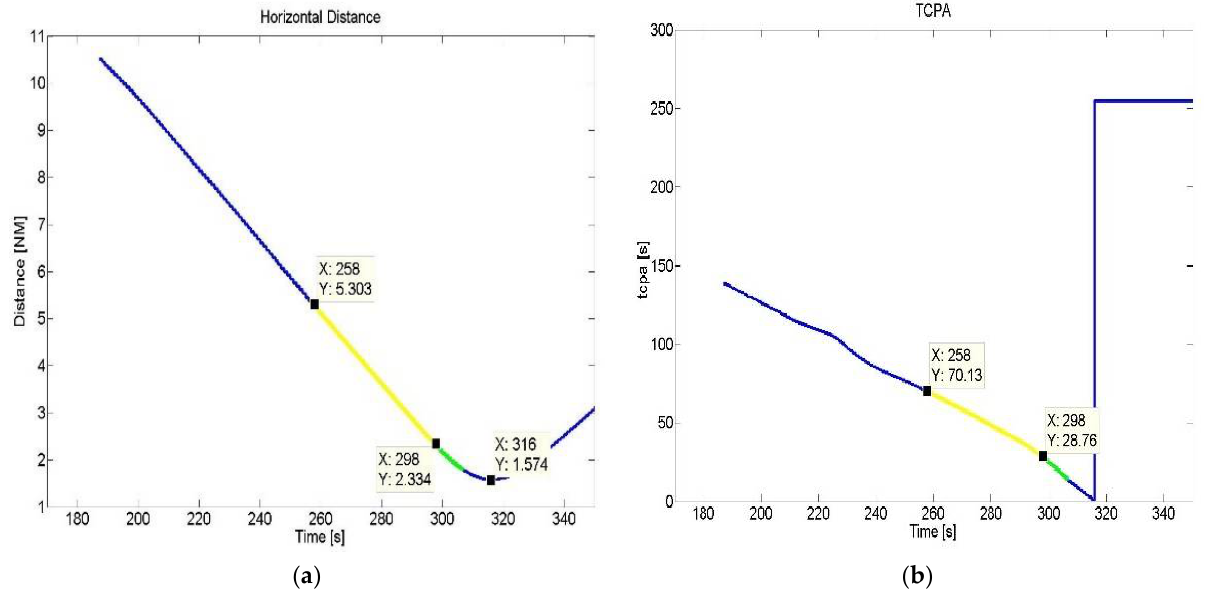
Figure 18. ( a ) Relative distance between the RPAS and the intruder during the encounter of Figure 16. The Caution alert activates at 5.3 NM of distance while the RWC maneuver is executed at about 2.5 NM, determining a minimum distance between the aircraft of about 1.5 NM, well outside the Well Clear Volume. ( b ) Time to closest point of approach during the encounter. The Caution alert activates at 70 s of t CPA giving to the RP the time to contact the controller and receive the clearance to execute the RWC maneuver at about 32 s of t CPA, avoiding the LoWC.